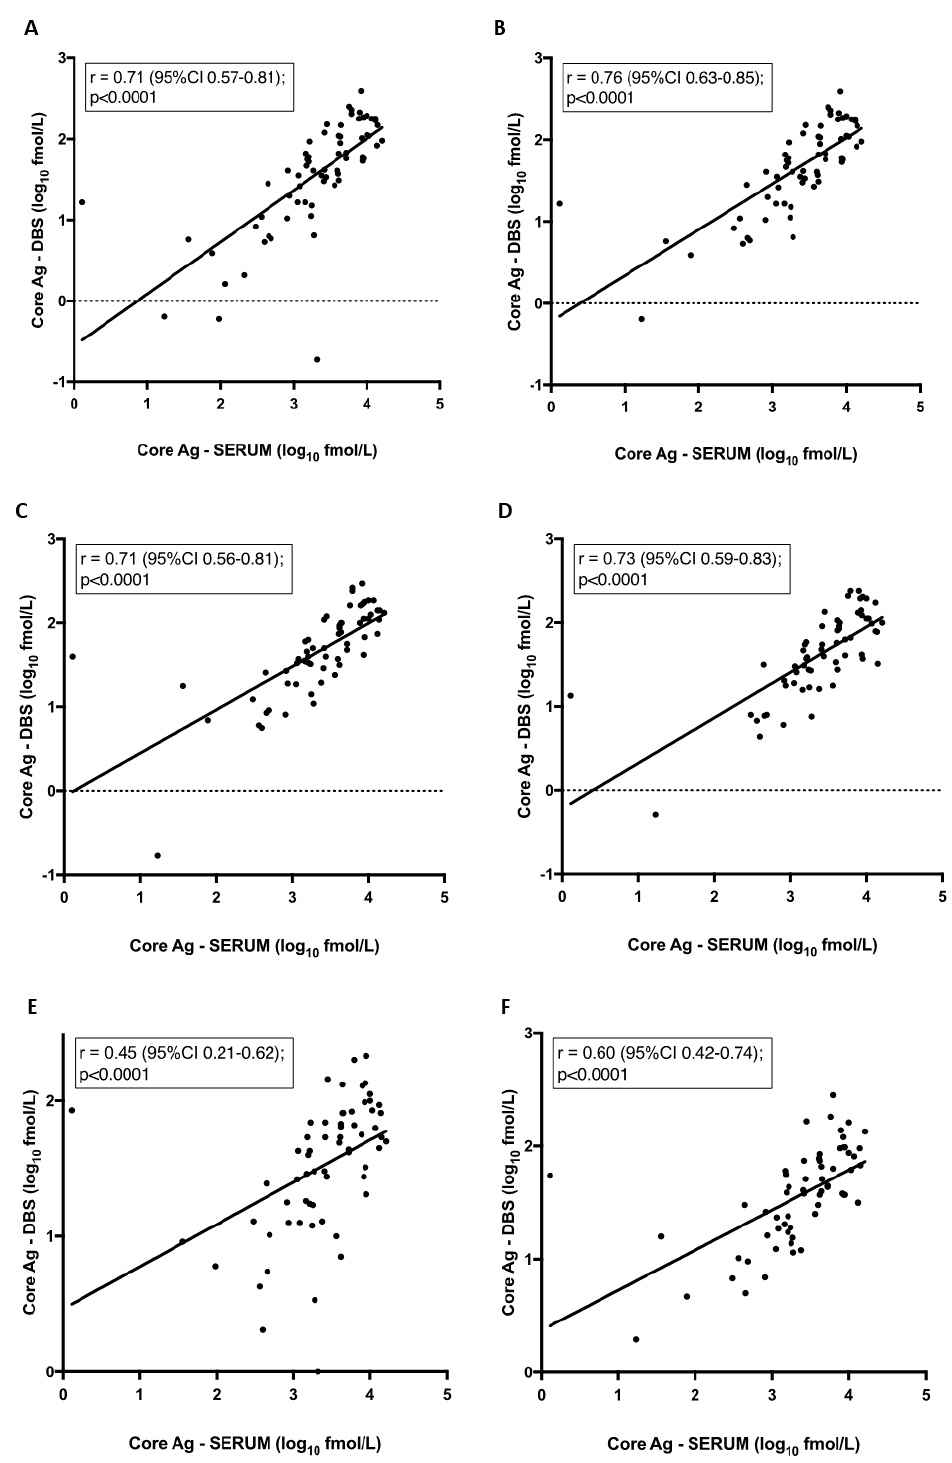
Figure 2. Correlation between core-antigen (Ag) titre from dried blood spots (DBS) and serum per condition. Pearson correlation: ( A ) Samples stored at − 80 °C. Samples excluded if core-Ag concentration was less than 3 fmol/L stored at ( B ) − 80 °C, ( C ) 4 °C, ( D ) 21°C, ( E ) 37°C, ( F ) 37 °C/4 °C. 3.4. Core Antigen (Ag) Sensitivity is Increased by Dried Blood Spots (DBS) Number